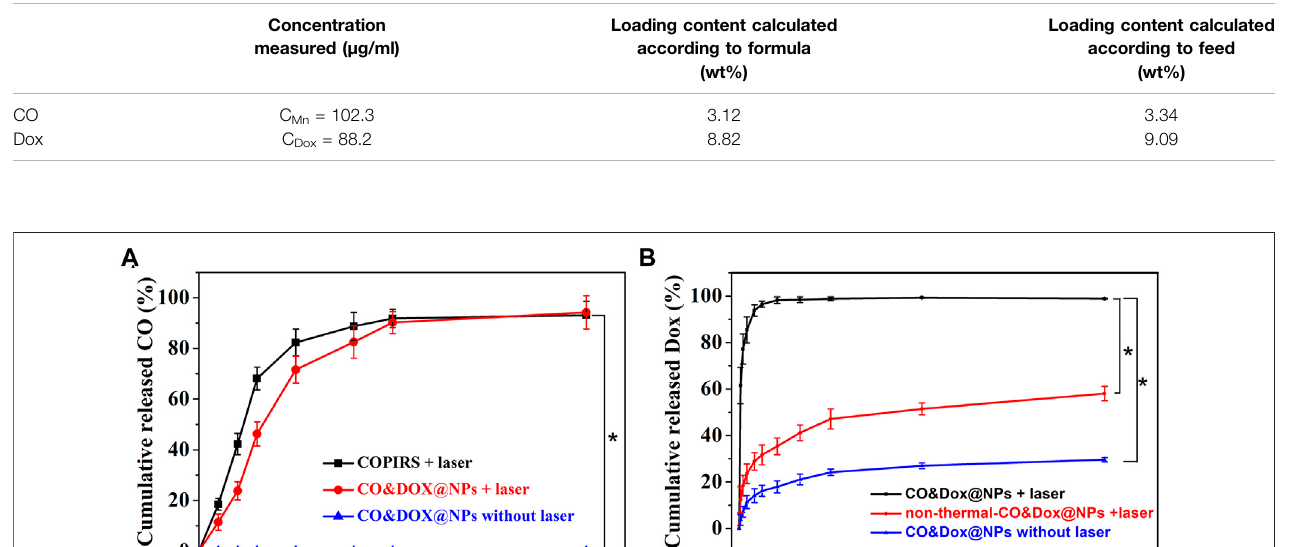
TABLE 2 | CO- and Dox-loading content.